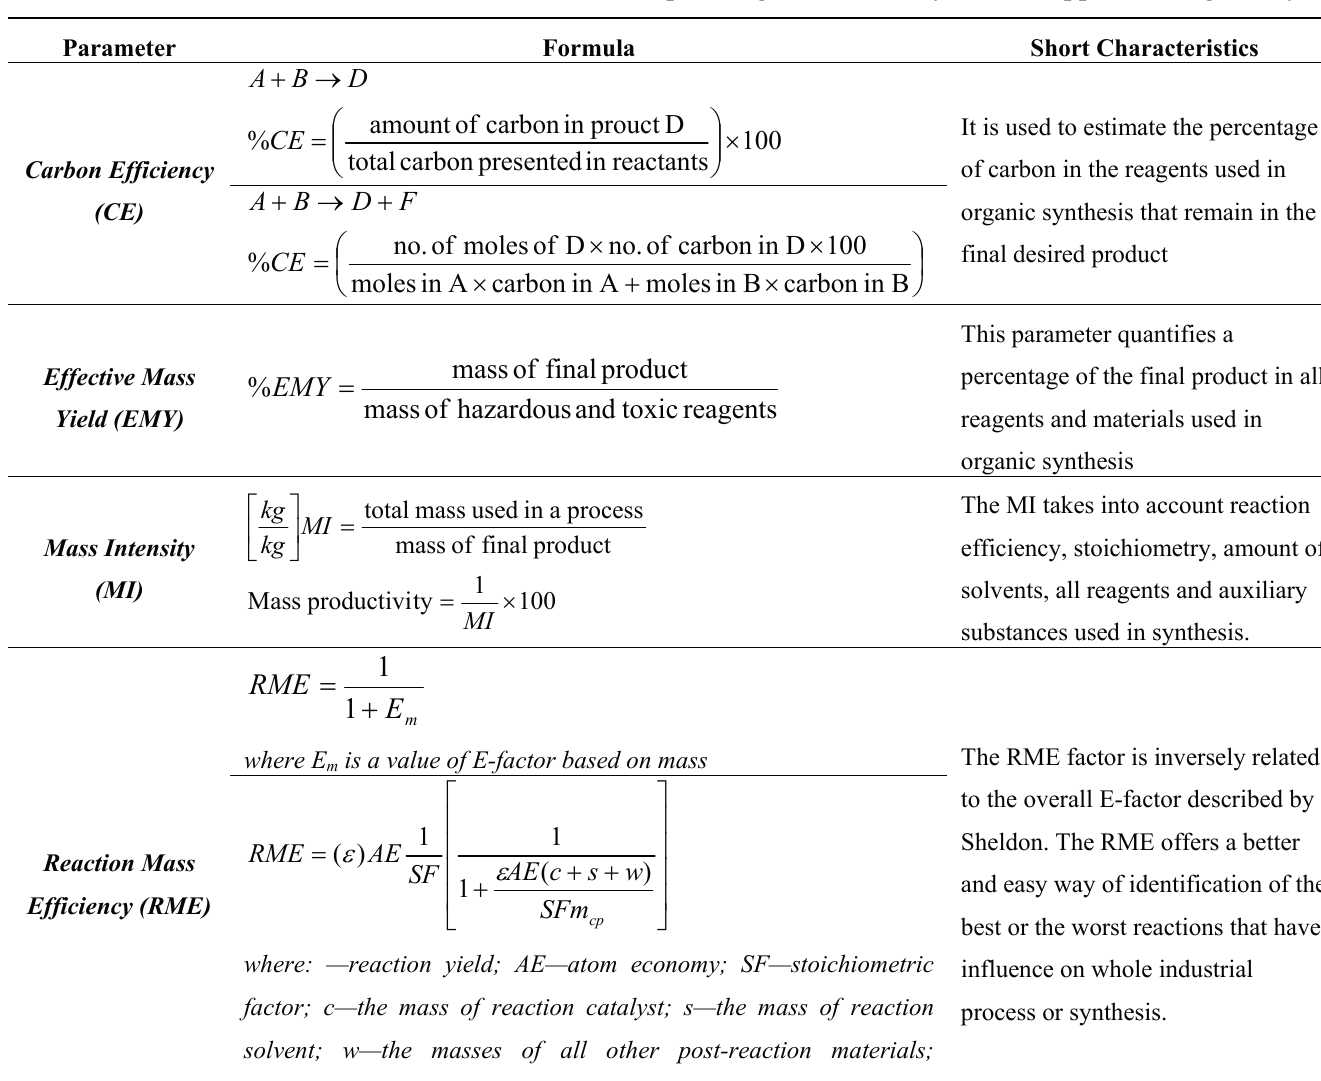
Table 2. Examples of green chemistry metrics applied to organic